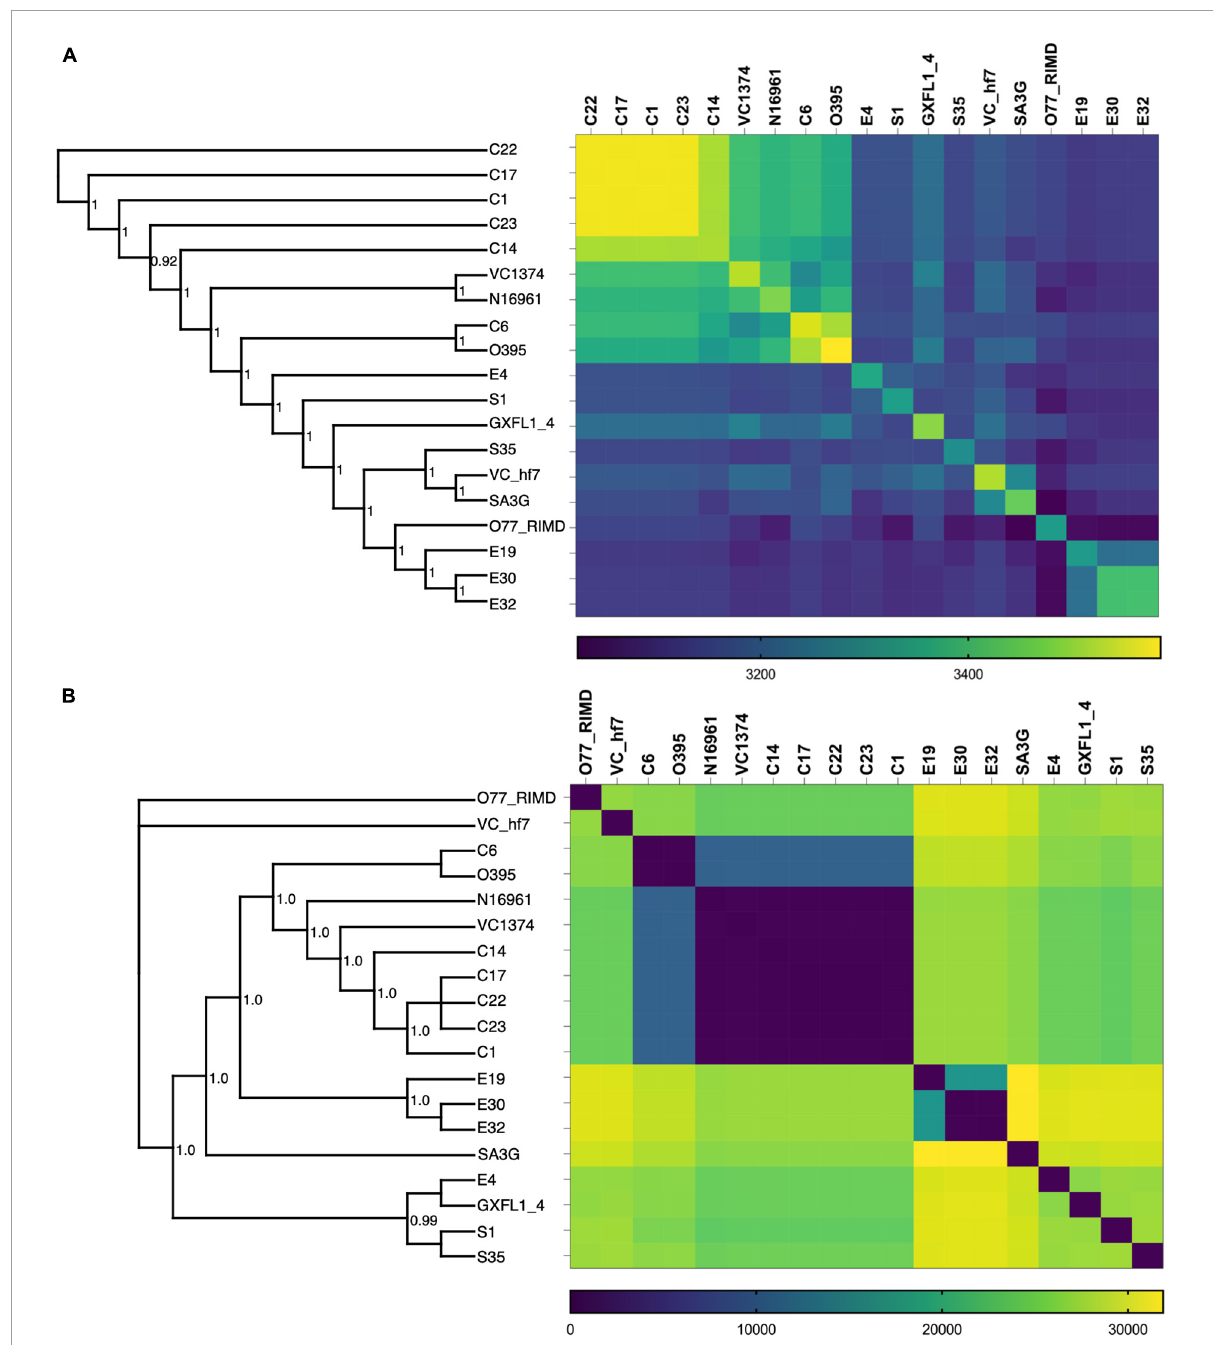
FIGURE1 Ortholog and SNP-based phylogeny of the V. cholerae isolates. (A) Combined whole genome phylogenetic tree and Ortholog-based matrix showing the relatedness and divergence of the isolates based on the ortholog assignment of genes. (B) SNP-based phylogenetic tree and matrix showing the relationship between the clinical and environmental isolates. Included in the analysis are the V. cholerae strains N16961, VC1374, O395, GXFL-4, VC-hf7, SA3G, and O77 RIMD genomes obtained from the NCBI